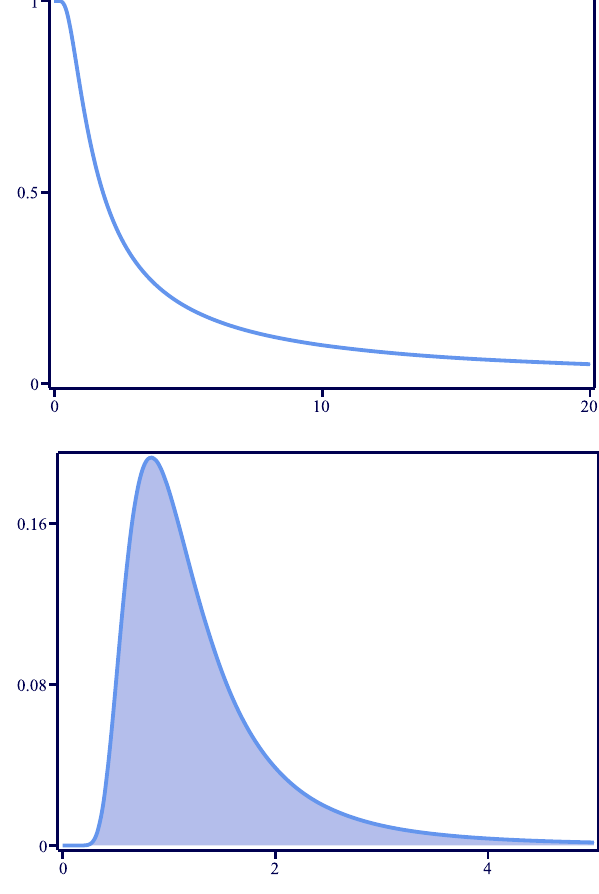
Fig. 7 Thetopandbottompanelsshowthesolutionandenergydensity in Eq. (54),